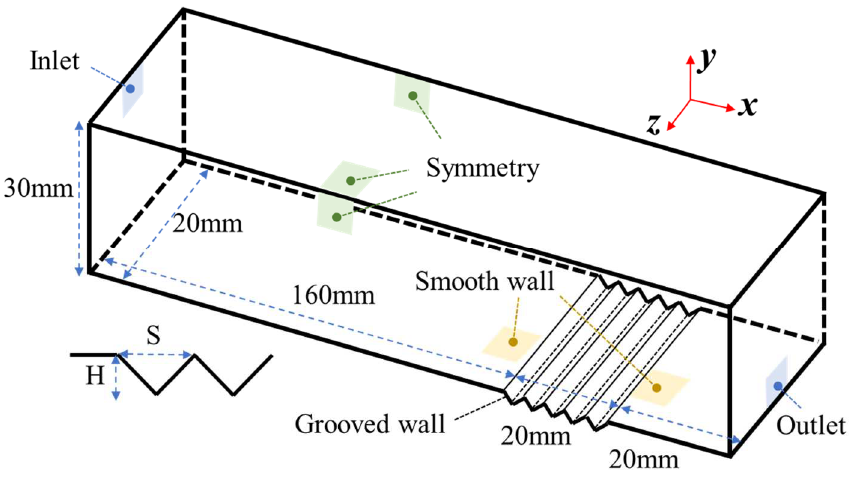
Figure 13. Computational domain and boundary conditions. Table 1. Size of the computational domain and the corresponding number of grid nodes. Dimensionless